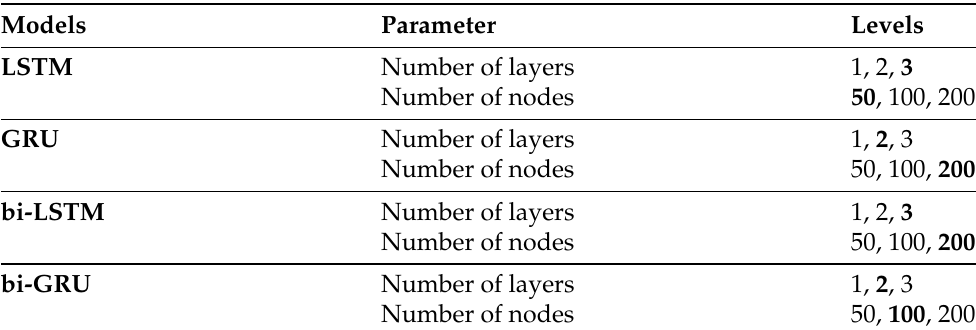
Table 4. Grid search parameters and levels for deep learning models when applying text preprocess- ing